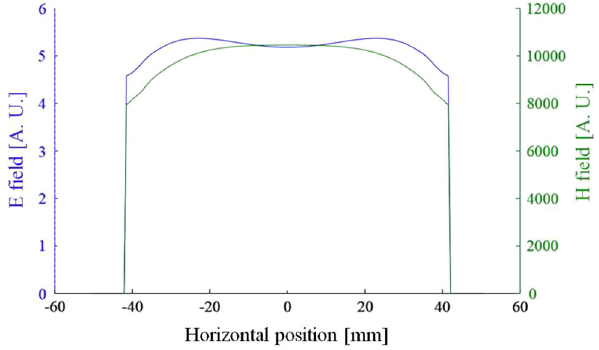
horizontal position in arbitrary units (A.